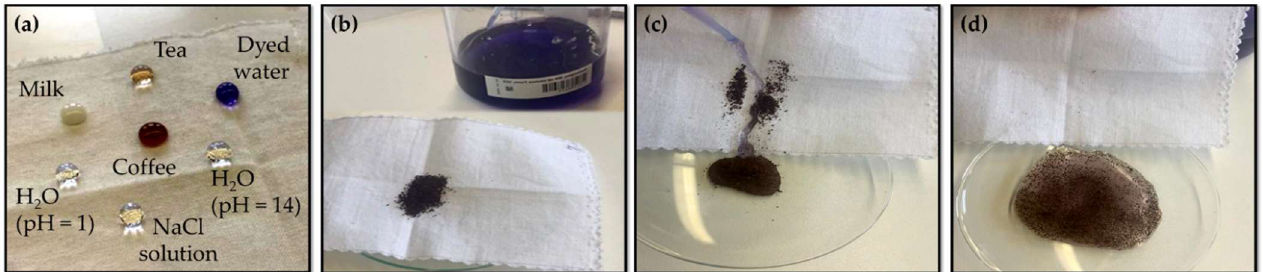
Figure 11. Photograph demonstrating the almost super-hydrophobicity of GC16_C′16-modified cotton textiles against various liquids ( a ) and real-time photographs demonstrating their water-based stain resistance performance ( b – d ).